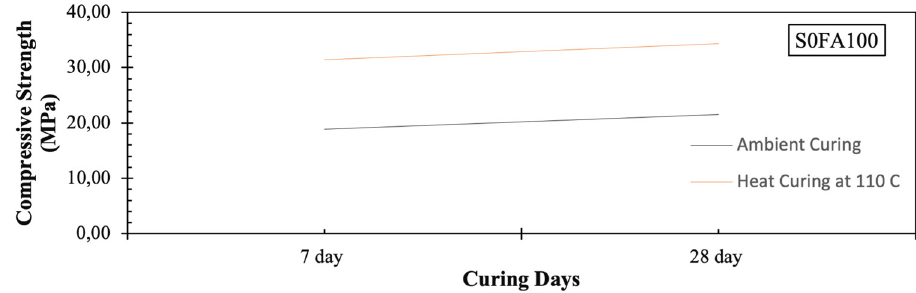
Figure 5: Compressive strength of ( 0GGBFS - 100FA